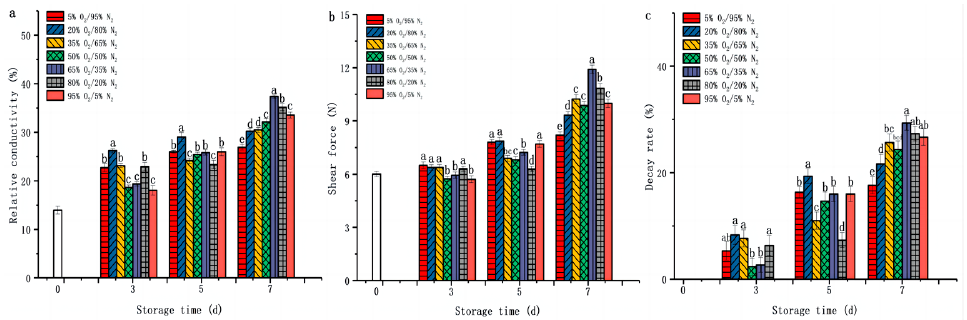
Figure 1. Effect of O 2 concentration (%) on relative conductivity ( a ), shear force ( b ), and decay rate ( c ) of fresh-cut Dictyophora rubrovolvata . Differences at p < 0.05 are indicated by different letters and data are expressed as the mean ± SD.